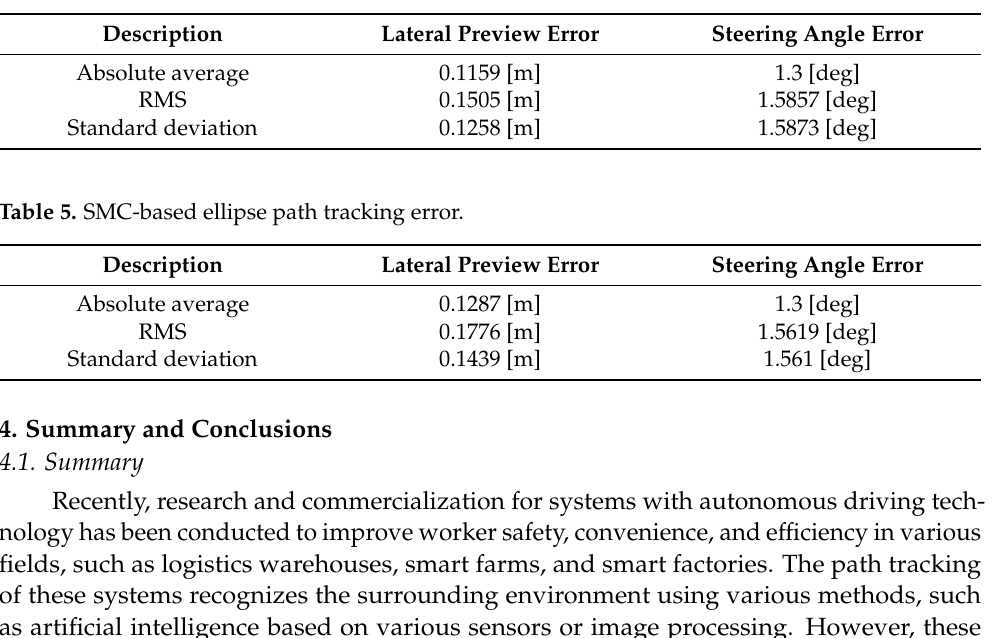
Figure 28. ( a ) LQR-based steering angle; ( b ) SMC-based steering angle; ( c ) LQR-based steering angle error distribution; ( d ) SMC-based steering angle error distribution. Table 4. LQR-based ellipse path tracking error.